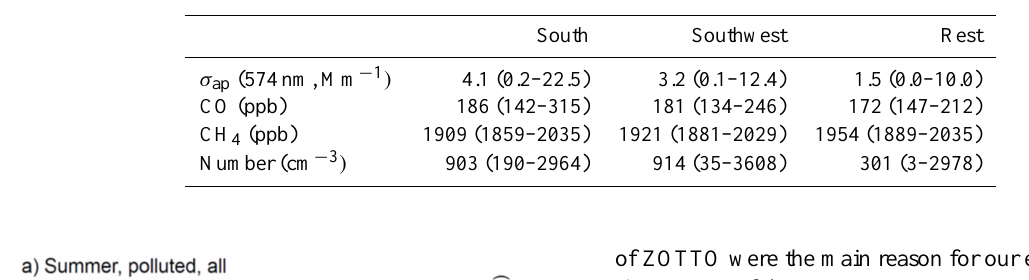
Table 4. Median and range for absorption coefficient, CO, CH 4 , and total aerosol number concentration from different airmass regions during winter polluted periods.